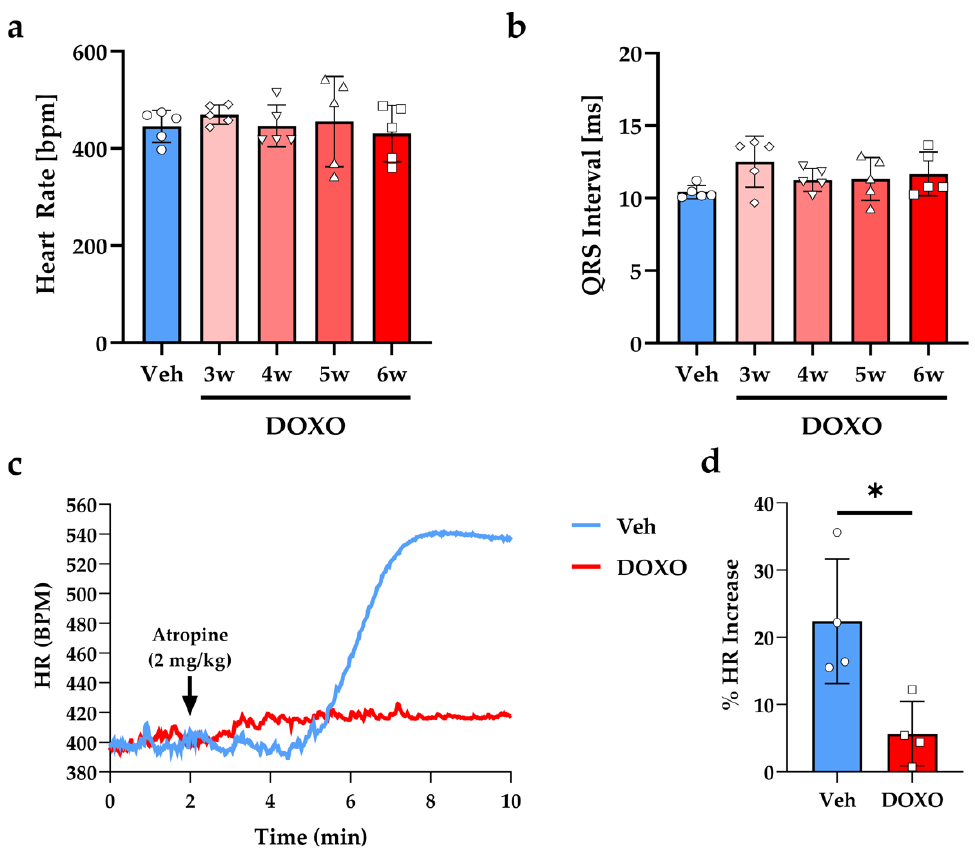
Figure 3. DOXO treatment affects cardiac sympathetic neuron function. ( a , b ) Electrocardiographic evaluation of heart rate (HR, ( a )) and QRS duration ( b ) in the DOXO- vs. vehicle-treated mice, at different time points after the completion of DOXO administration. ( c ) Representative trace of HR increase in a vehicle- vs. a DOXO-treated mouse upon Atropine injection. ( d ) Evaluation of the fractional HR increase 5 min after atropine administration. Bars represent the s.d. Differences among the groups were determined using an unpaired t -test. (n = 4 mice for each group; *, p < 0.05). DOXO, doxorubicin; Veh, vehicle; BPM, beats per minute.